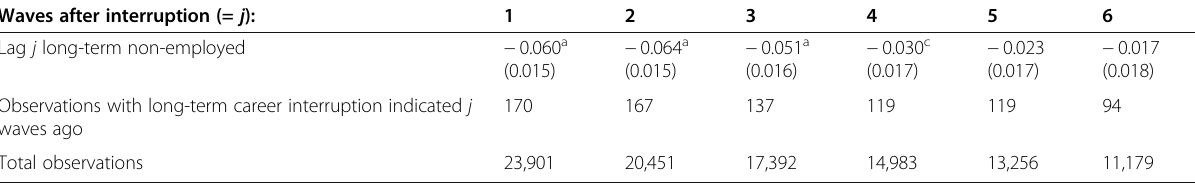
Table 5 Future wage effects of a long-term non-employment spell for workers older than 35 years. Dependent variable: log real hourly wage, j waves after the interruption Waves after interruption (= j ):